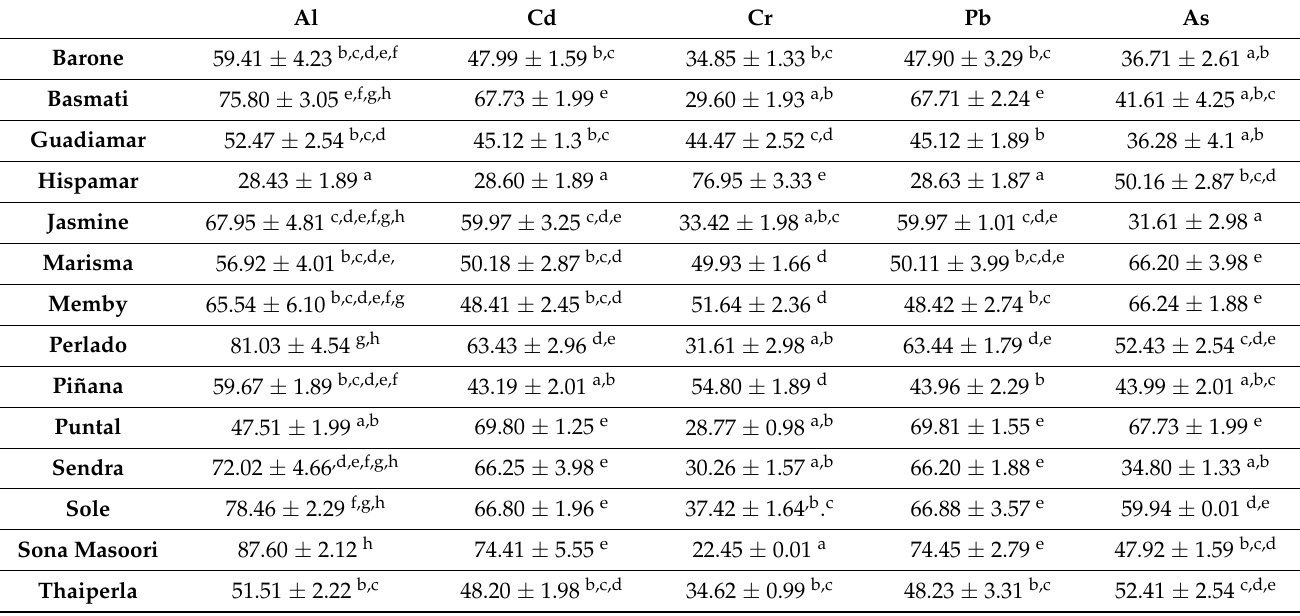
Table 10. Percentage of metallic elements bioaccesibility (%).